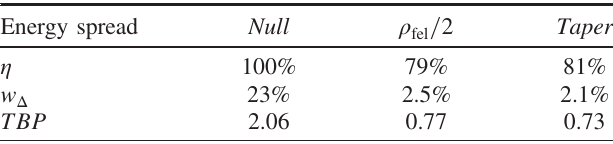
= 2 ), and tapered fel ¼ 4% t